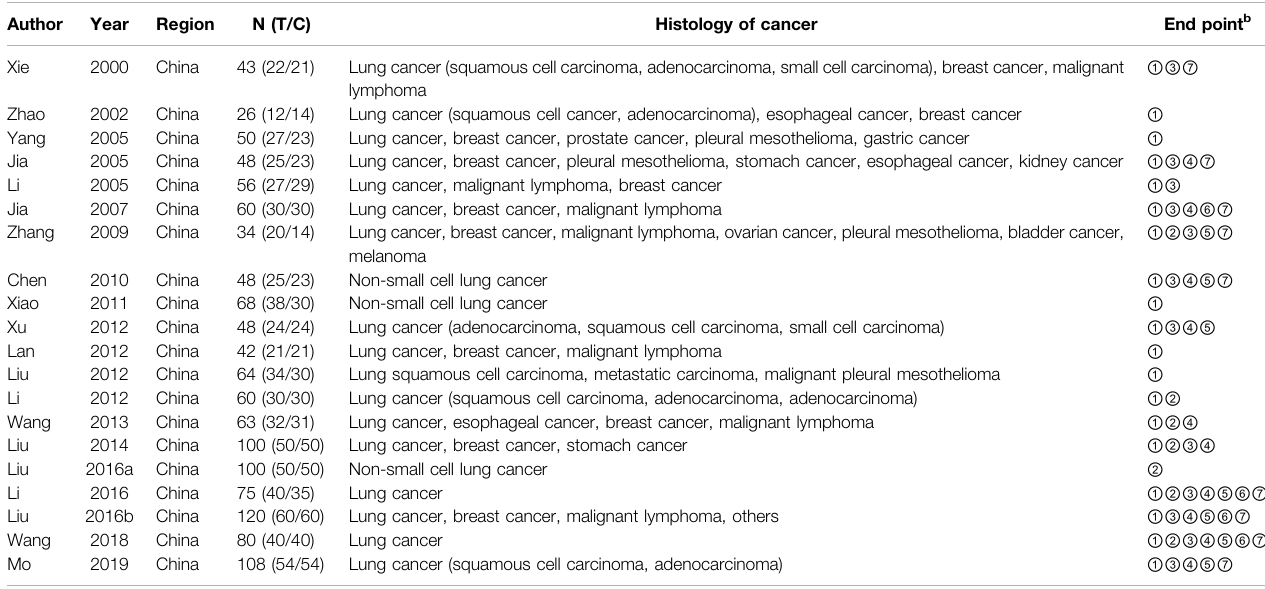
TABLE 1 | Data analysis of included